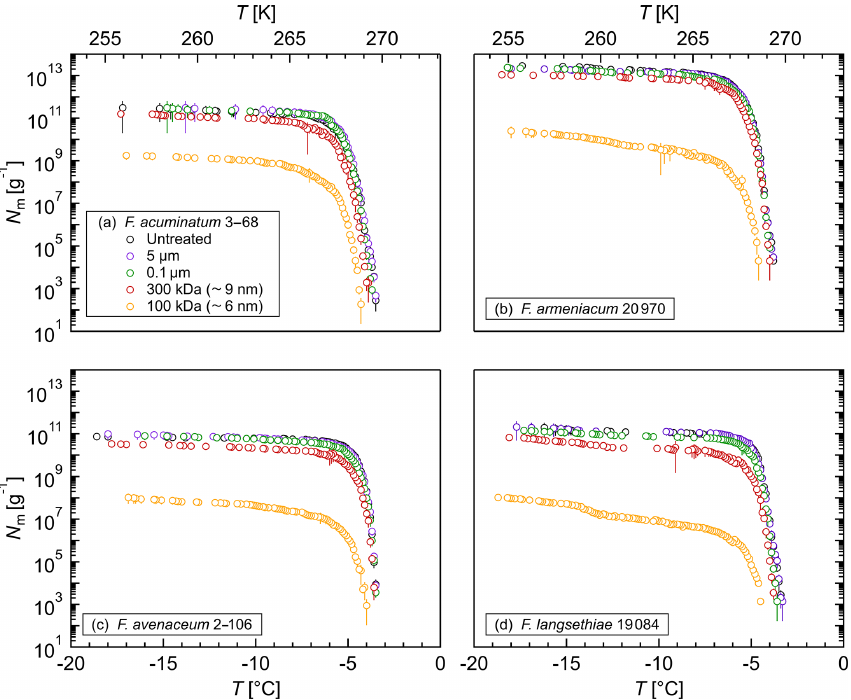
Figure 2. Size determination of the Fusarium IN upon filtration: cumulative number of IN ( N m ) per gram of mycelium plotted against the temperature ( T ) for (a) F. acuminatum 3–68, (b) F. armeniacum 20970, (c) F. avenaceum 2–106, and (d) F. langsethiae 19084. The error bars were calculated using the counting error and the Gaussian error